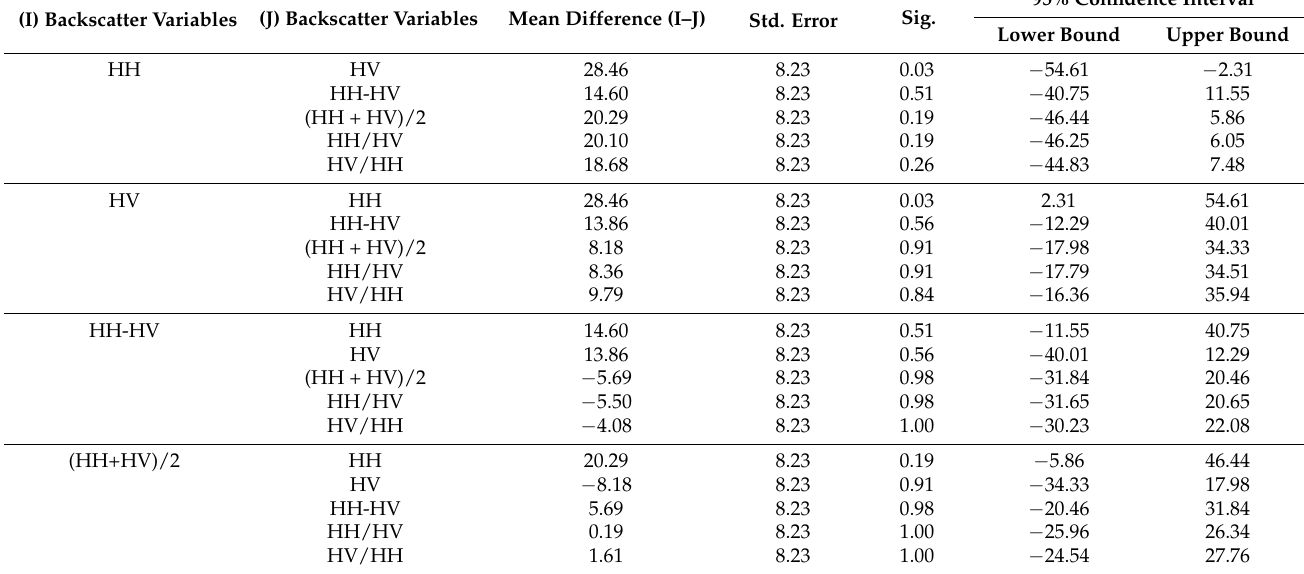
Table 7. Multiple comparisons of backscatter variables on BCR (%) obtained from Tukey’s honest significant difference (HSD)